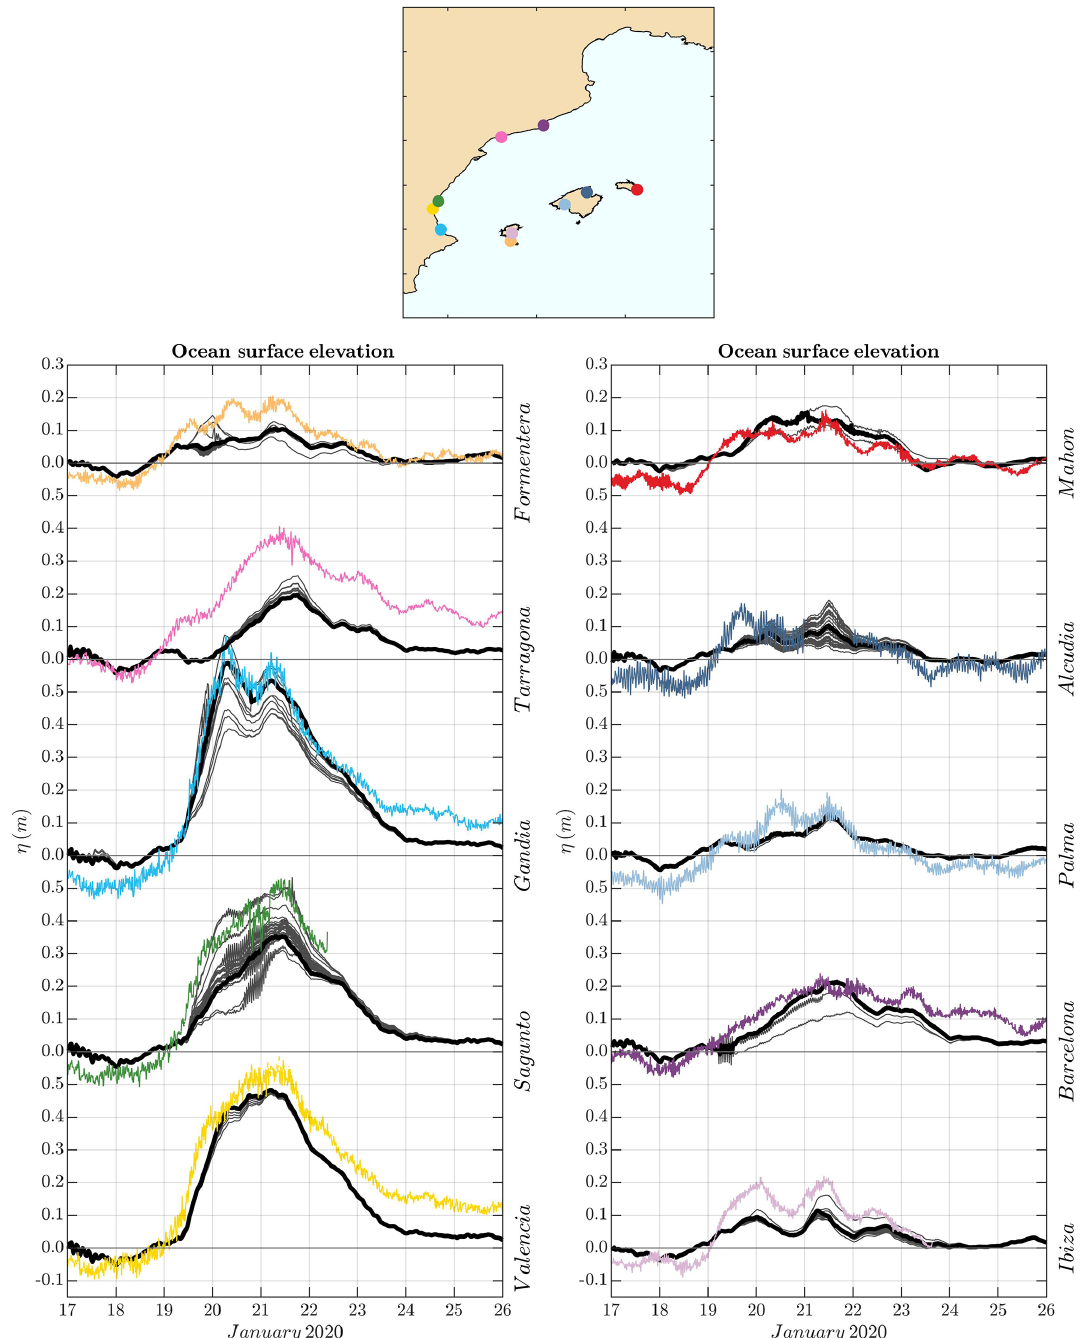
Figure 4. Comparison between modelled (black lines) and observed (coloured lines; each colour corresponds to one location in the map) storm surges by tide gauges. To avoid strong bathymetric dependencies, the time series of all modelled points closer to 2.5km to the tide gauge location are shown. The closest modelled point to the tide gauge is indicated by a thick black